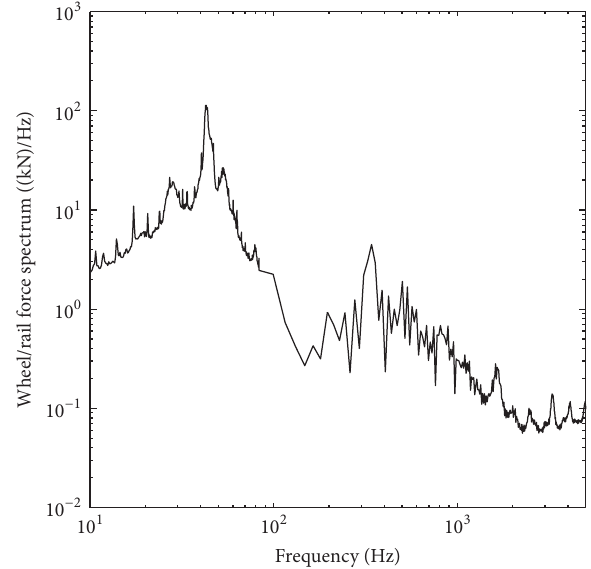
Figure 6: The amplitude spectrum of wheel/rail force.